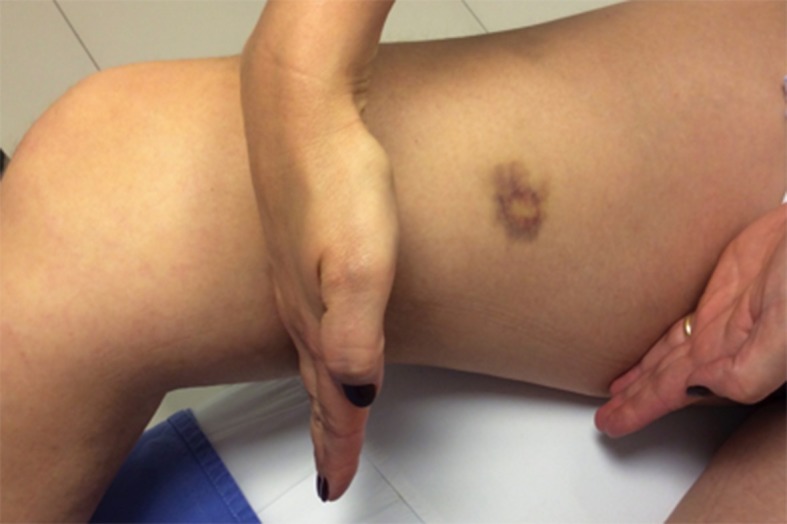
Control on day 7. Patient in group treated with tumescence, with minor bruising, indicating location of paresthesia.